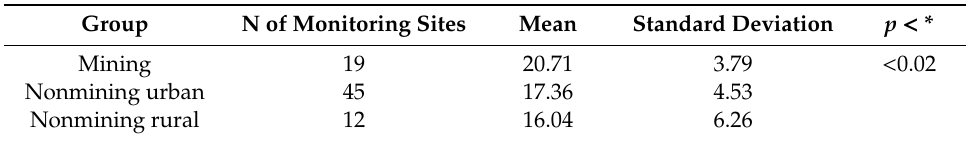
Table 5. Mean and standard deviation PM10 levels ( µ g / m 3 ) for 2017 at community air monitoring stations in Queensland and New South Wales. Group N of Monitoring Sites Mean Standard Deviation p < *